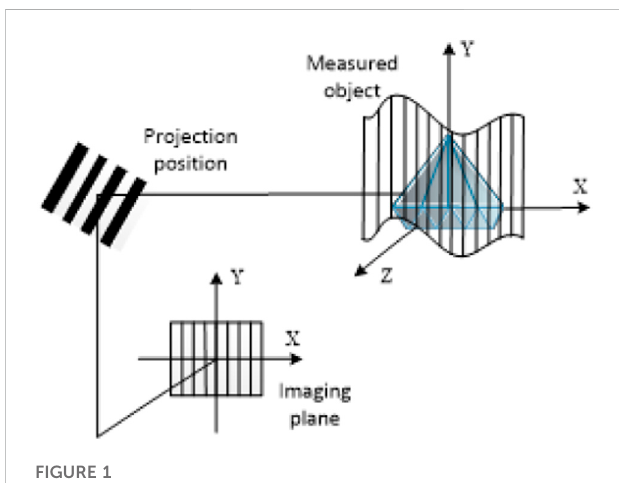
FIGURE 1 Multiline structured light measurement principle.